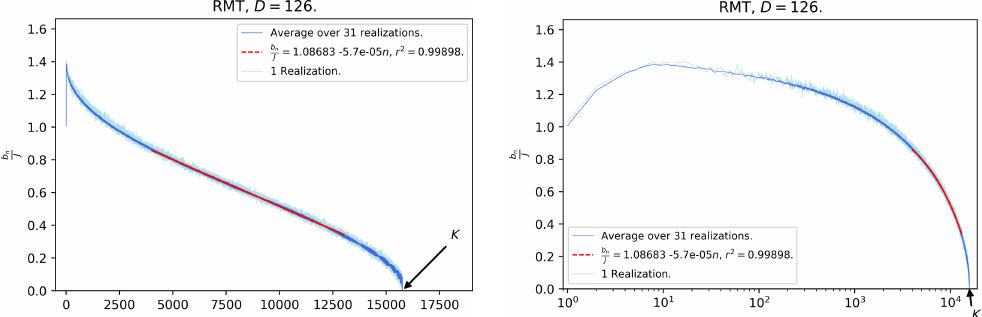
Figure 8 . Lanczos sequence for RMT drawn from the GUE with potential (A.1). The Hilbert space dimension was chosen to match that of cSYK with L = 9 and N = 5 . The right panel features the same data, with logarithmic scale along horizontal axis, allowing more resolution on the initial part of the